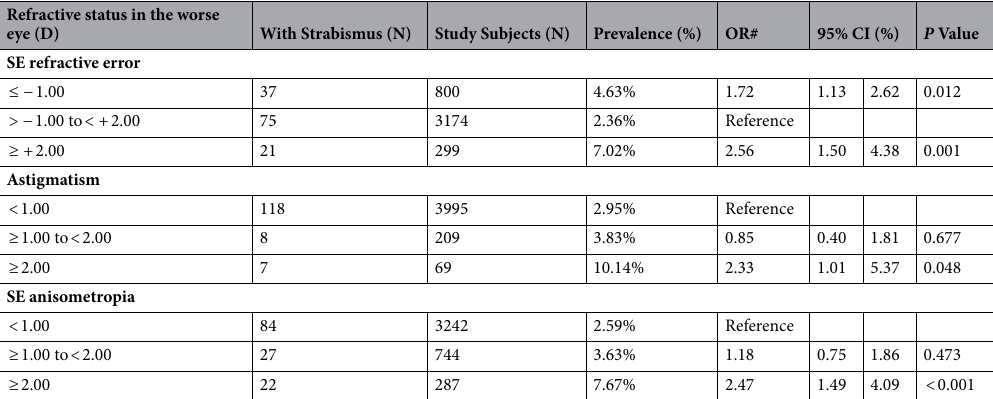
Risk factors Study subjects